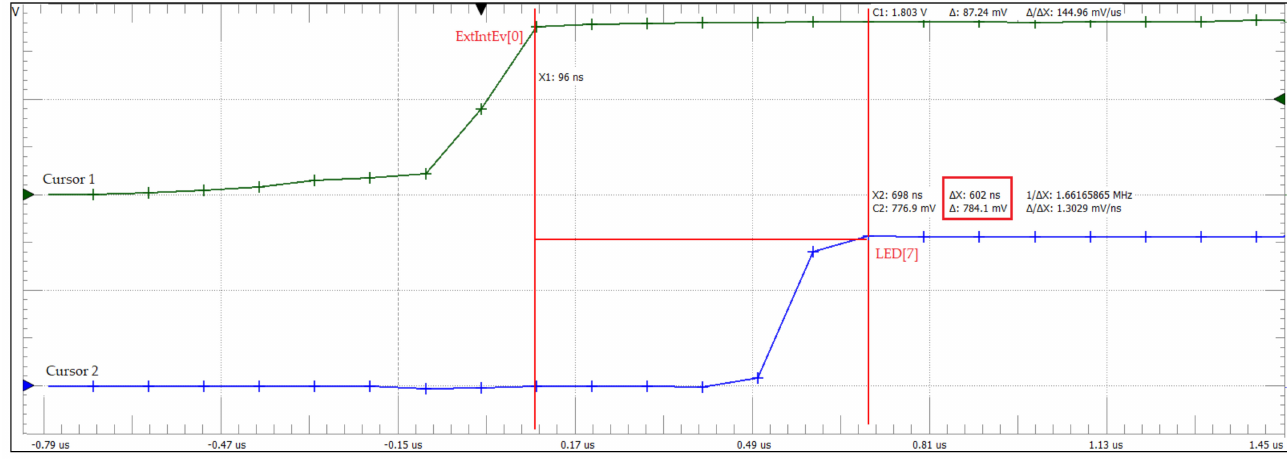
Figure 9. Kernel latency based on the hardware search in grMutexi[i] registers (602 ns, including the external interrupt threading).